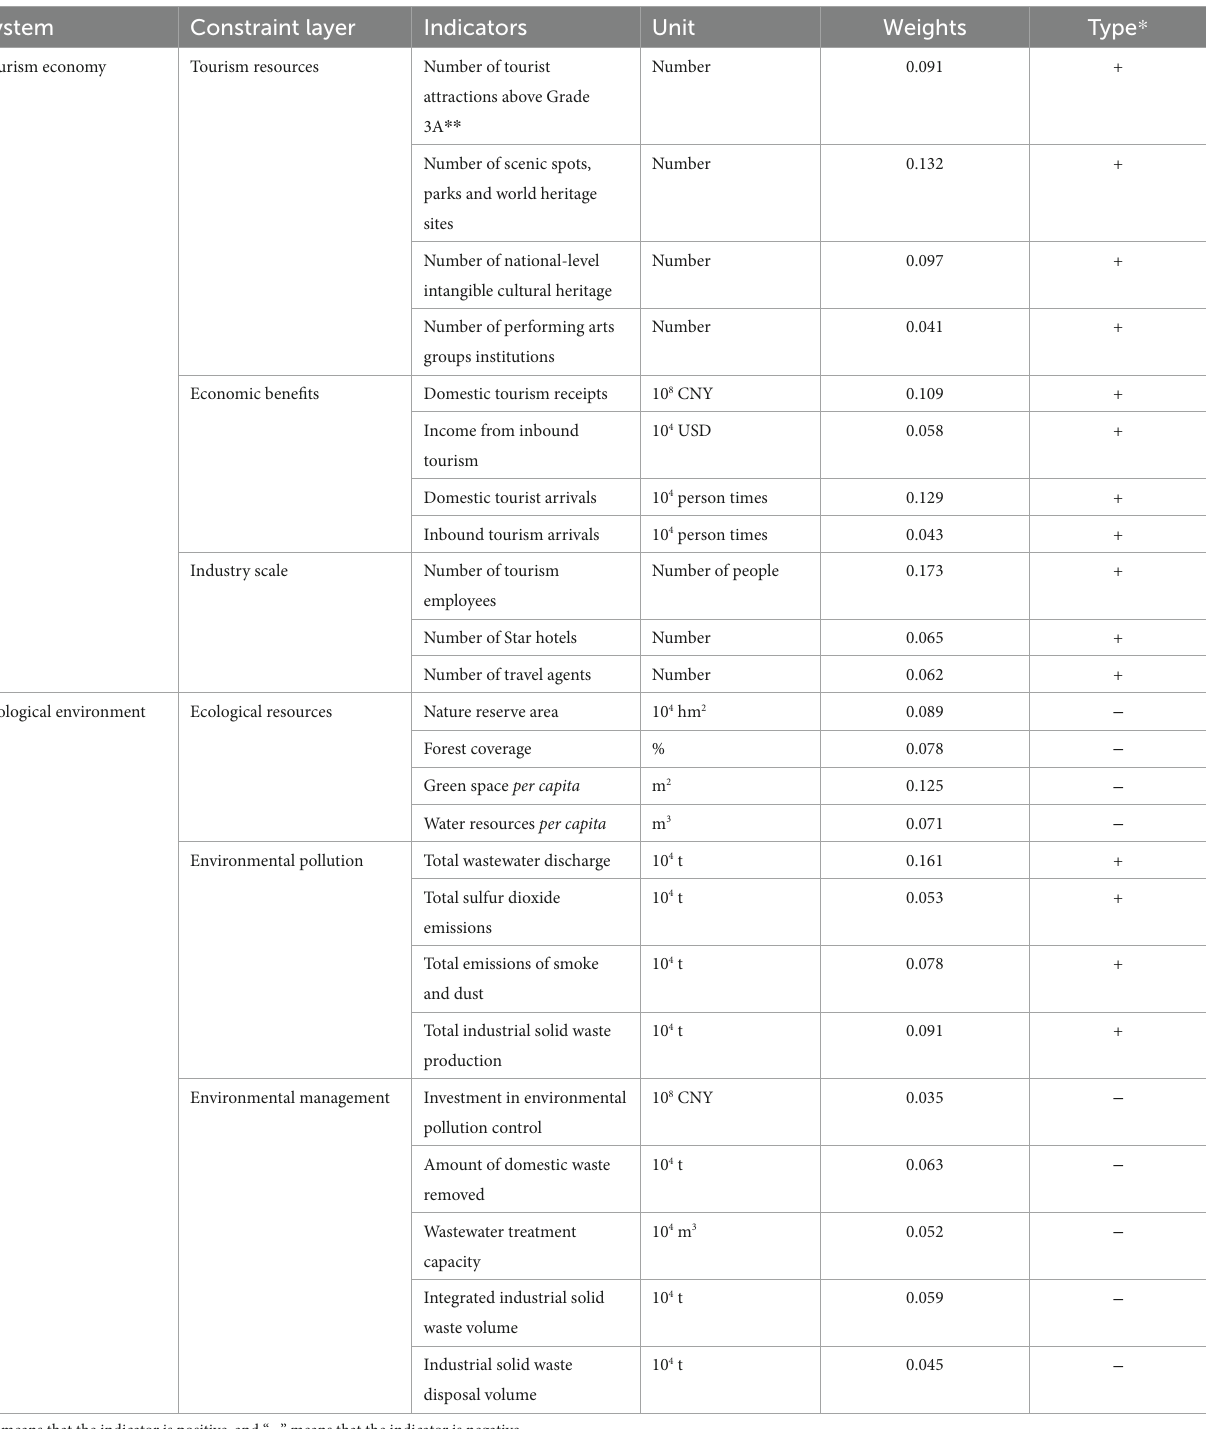
TABLE 1 Decoupling analysis system and index weight of tourism development and ecological environmental